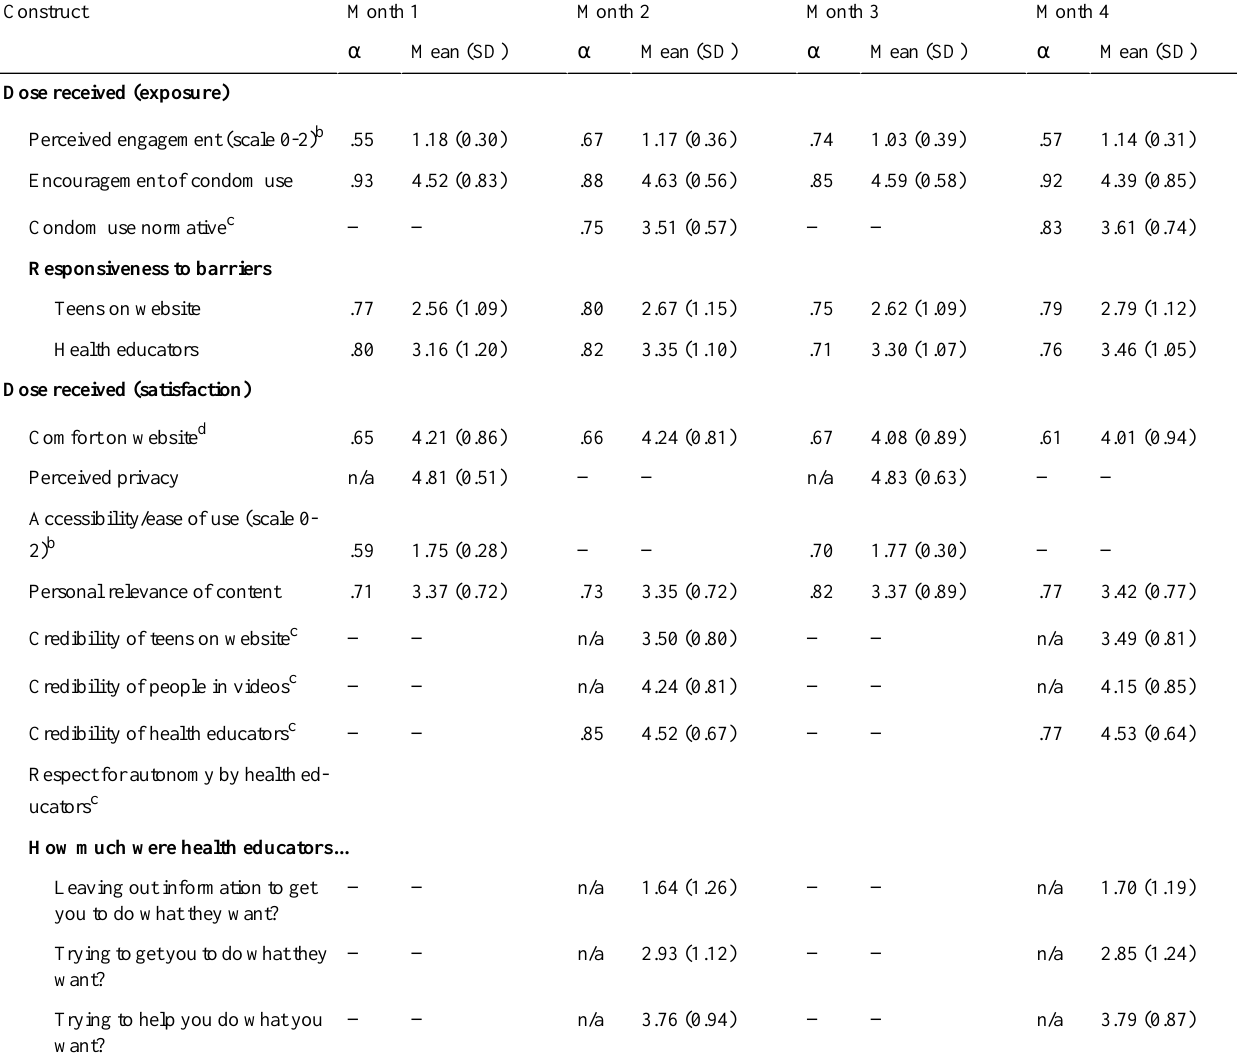
Table 3. Participant responses to monthly survey items designed to evaluate website development goals and internal consistency (alpha) of composite measures.